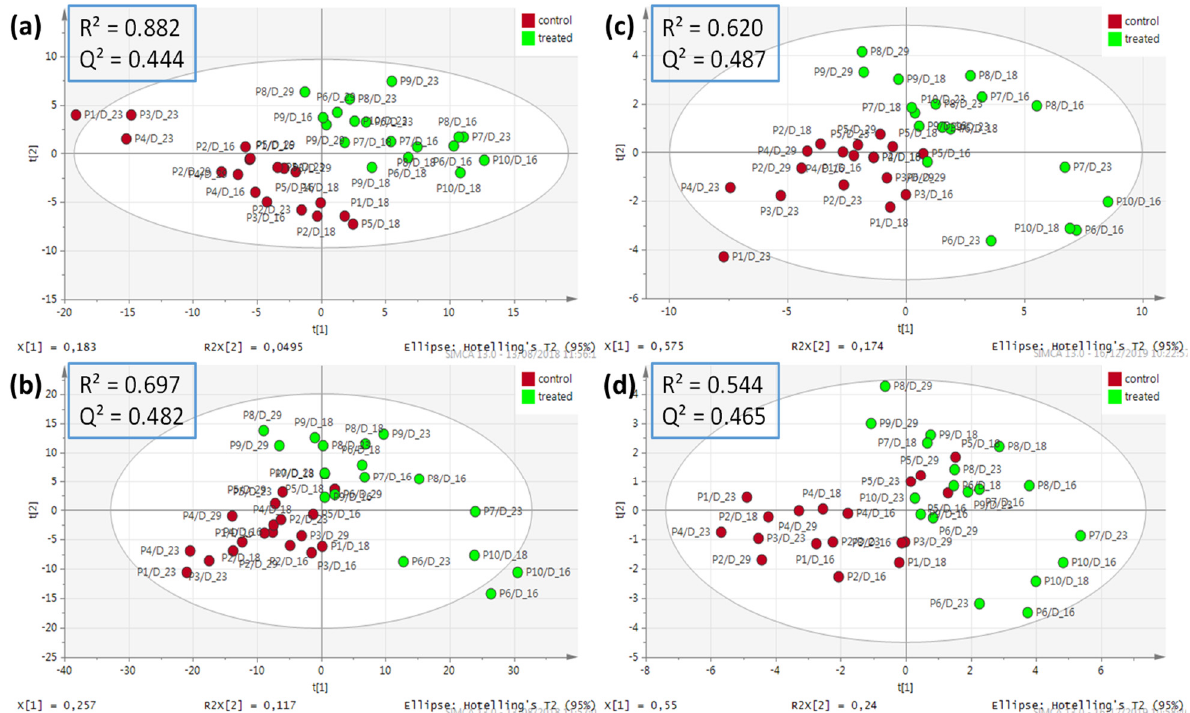
Figure 1. PLS-DA score plots after removing QC, D0, D3, D9 samples from the cleaned ESI − and ESI+ datasets acquired with RP UHPLC-HRMS. Datasets containing 1612 (ESI − ) ( a ) and 2914 (ESI+) ( b ) features, n = 36. Reduced datasets containing 94 (ESI − ) ( c ) and 46 (ESI+) ( d ) features, n = 36. Log 10 transformation, Pareto scaling and centering were applied.